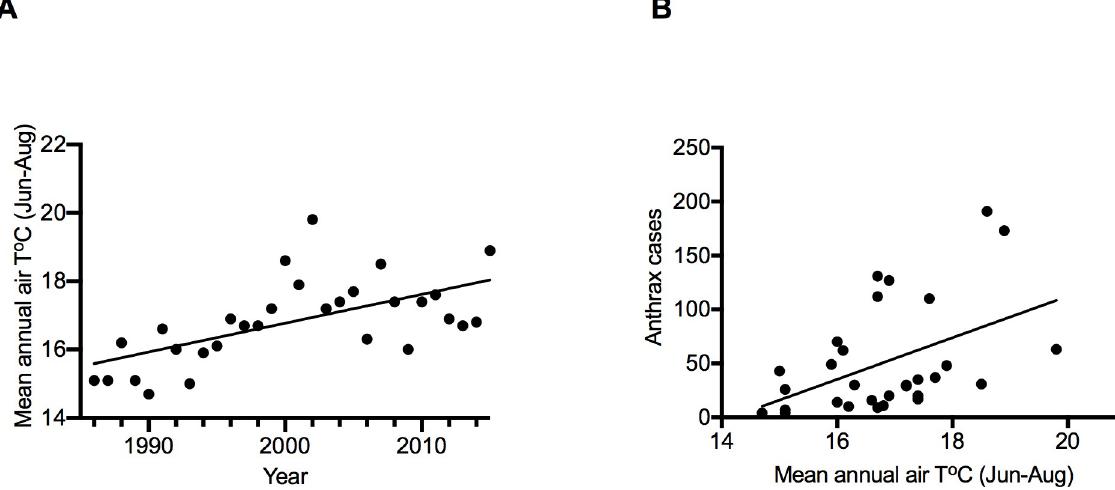
Fig 6. The magnitude of anthrax cases in relation to air temperature. (A) Linear regression of annual summer air temperature 1986–2015, slope = 0.08449 ± 0.02077, R 2 = 0.4, p < 0.001, 95% CI 0.4195–0.127. (B) Correlation between anthrax cases and annual summer air temperature from 1986 to 2015 r = 0.46, p = 0.0099, 95% CI 0.1238–0.7058.